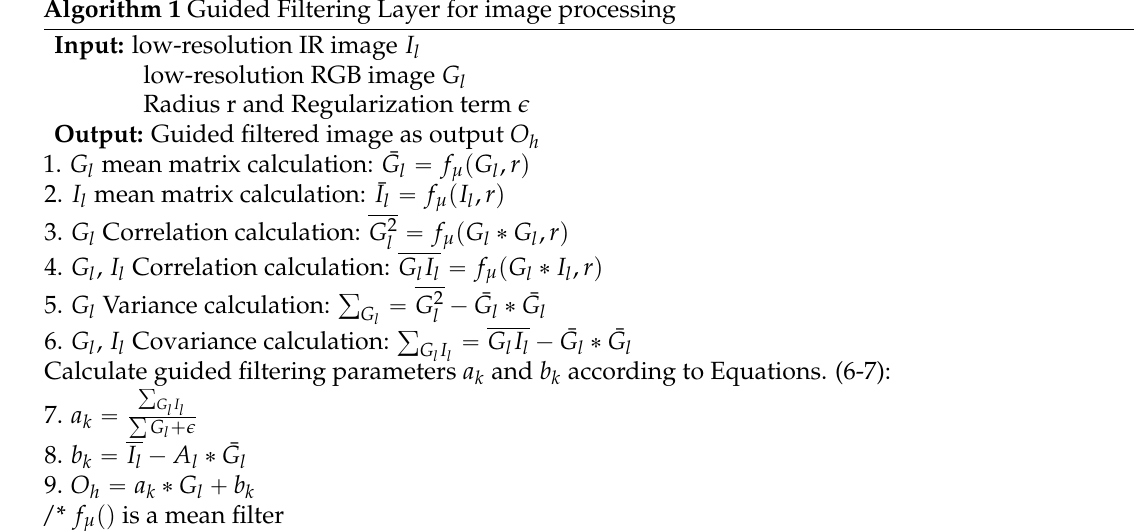
Algorithm 1 Guided Filtering Layer for image